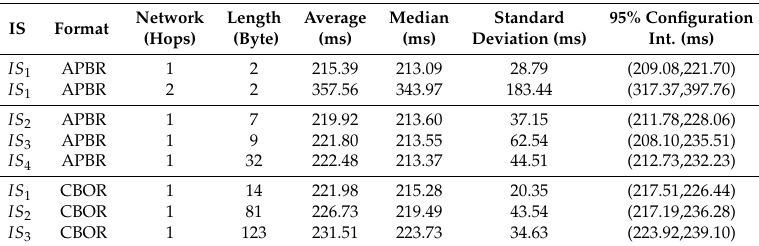
Table 10. Response time measures.